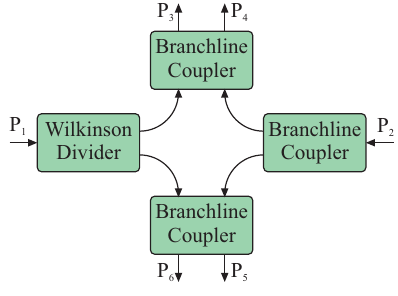
Figure 2. Passive structure of a six-port interferometer formed by three Branchline quadrature hybrid couplers and one Wilkinson power divider [28].